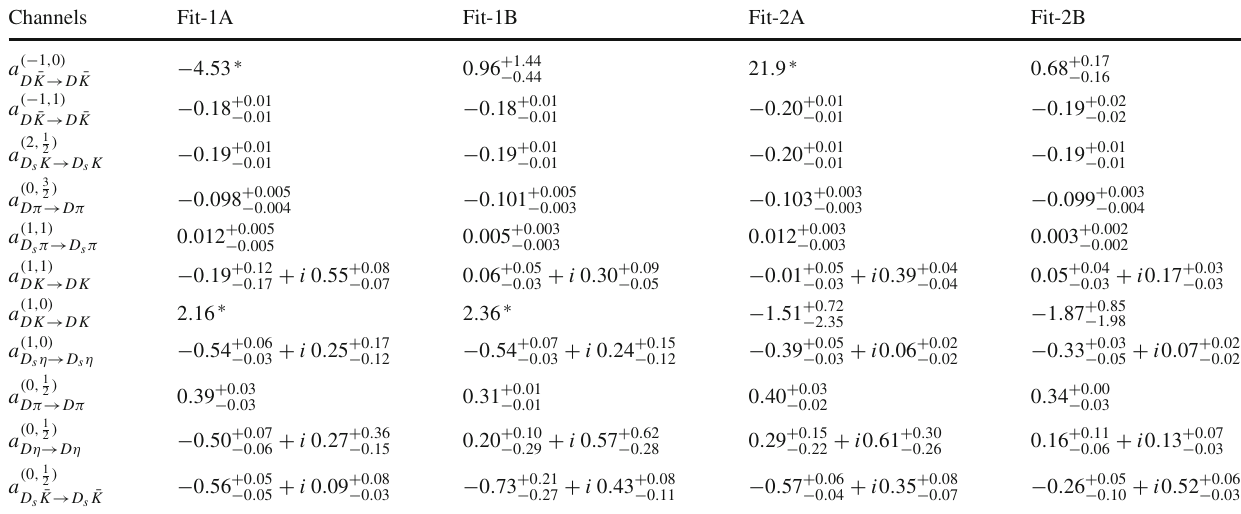
Table 6 Predictions of the S -wave scattering lengths for various channels obtained at the physical meson masses. The values are given in units of fm. For the entries marked by asterisks, only the central values are given. See the text for details